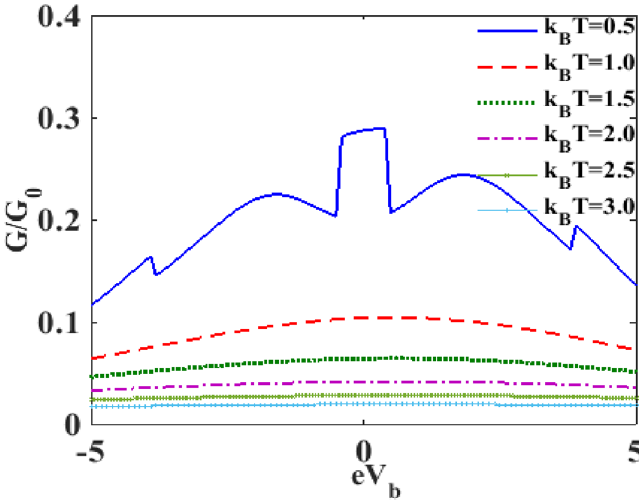
Figure 13. G / G 0 versus eV b for different values of k B T with (cid:31) = 0.6, eV m = 0.5, γ = 0.02 .